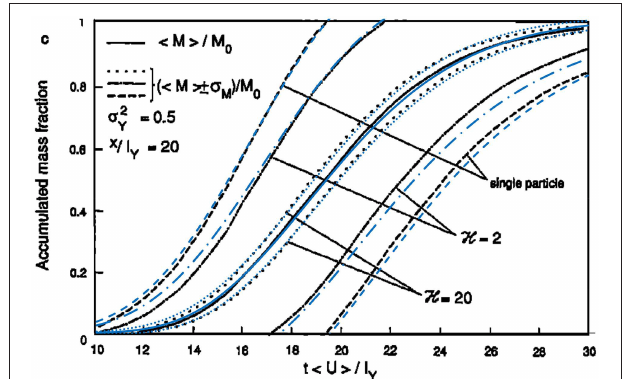
FIGURE 3 | Comparison of the proposed solution (11) with the results of Cvetkovic et al. (1992) (Figure 5C), for σ 2 Y = 0.5, x / I = 20 and a few values of the size of the initial plume ( L y / I = L z / I = H ). The figure displays the cumulative mass M and the bands M ± σ M predicted by the present approach (blue lines) over the original Figure 5C of Cvetkovic et al.